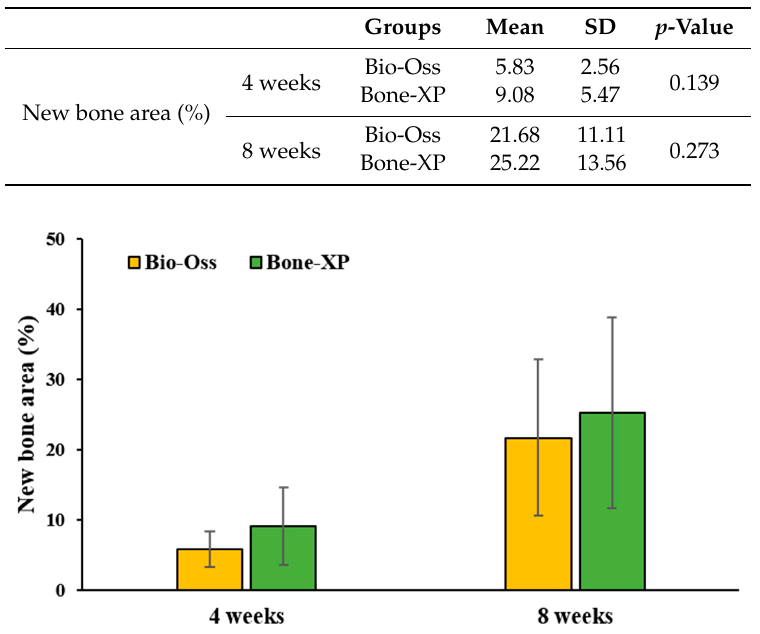
Table 3. New bone area within area of interest (AOI). (n = 5).